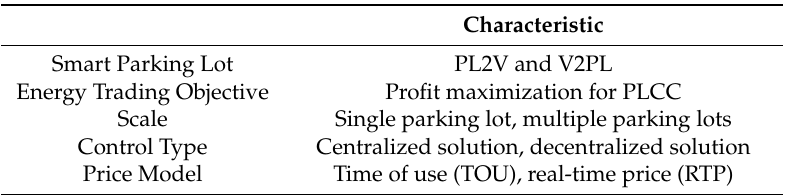
Table 1. Overview of proposed smart parking lot